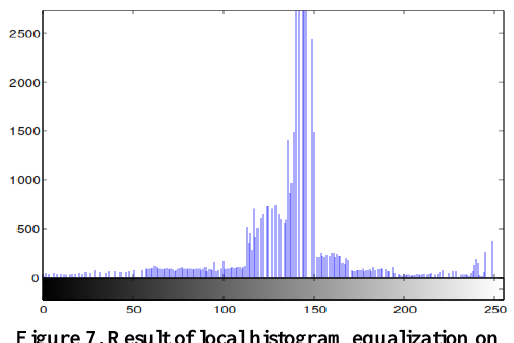
Figure 7. Result of local histogram equalization on secondary intervals formed by re-implantation of algorithm 1 on Figure